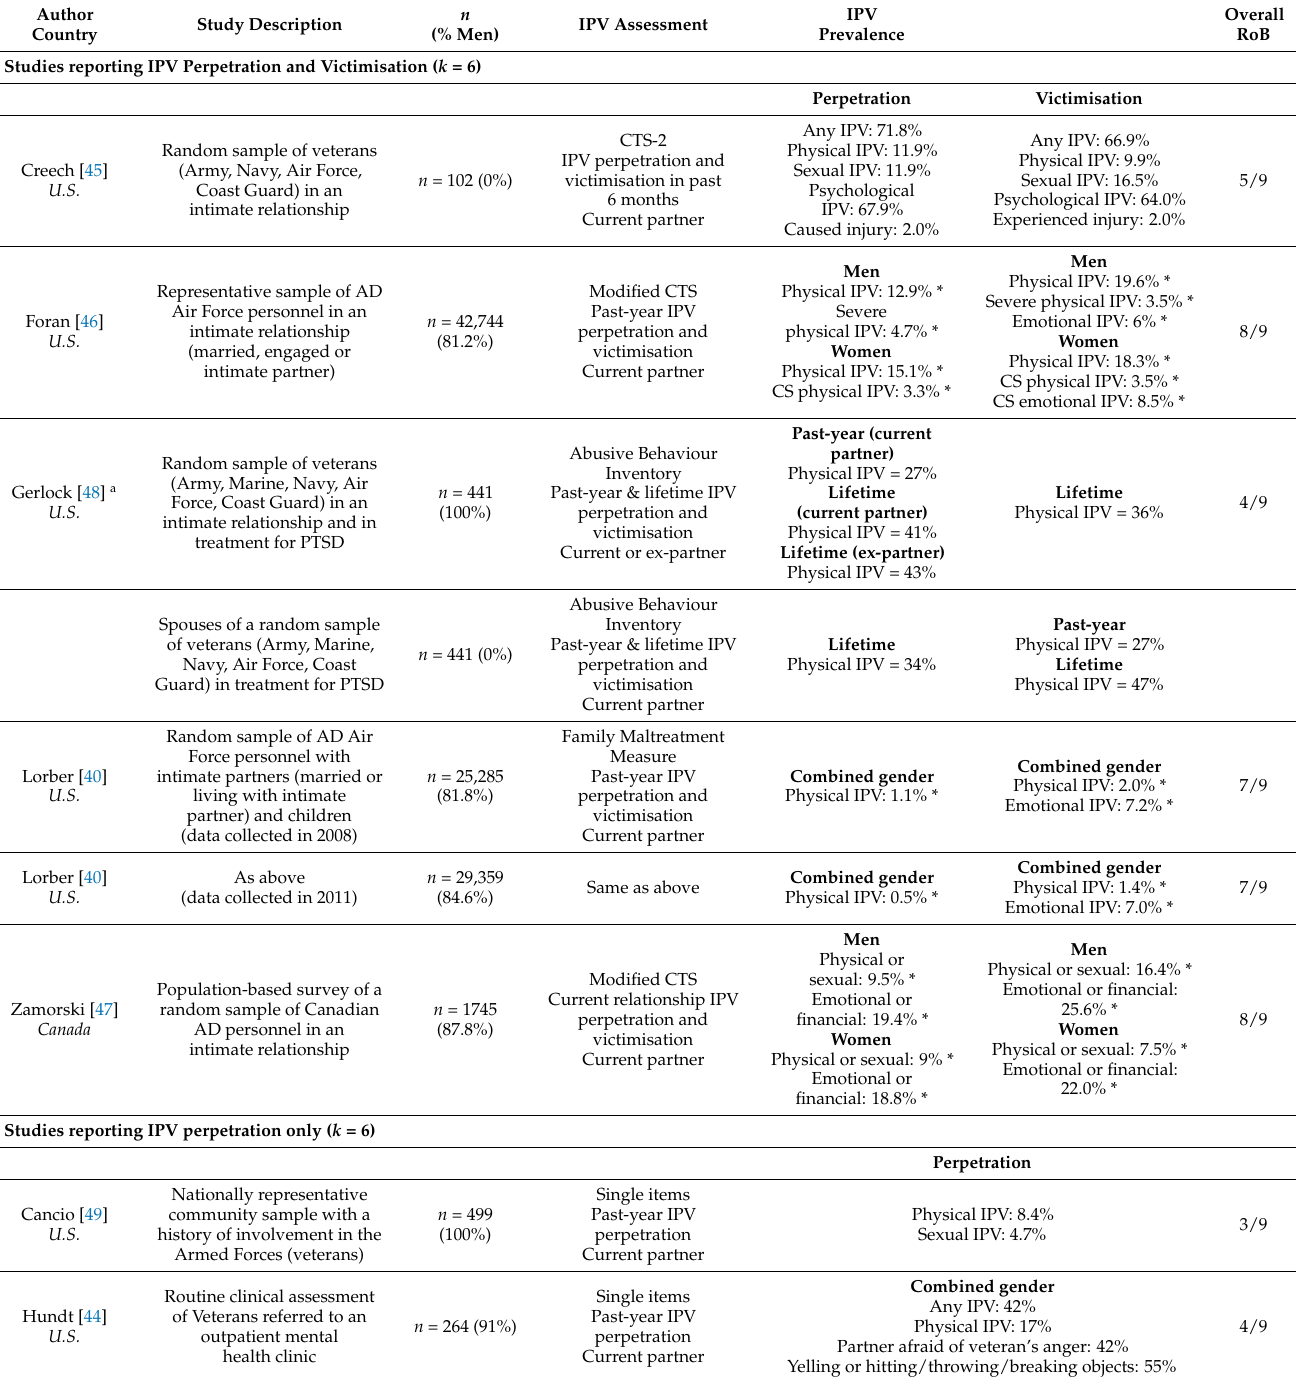
Table 1. Characteristics of eligible